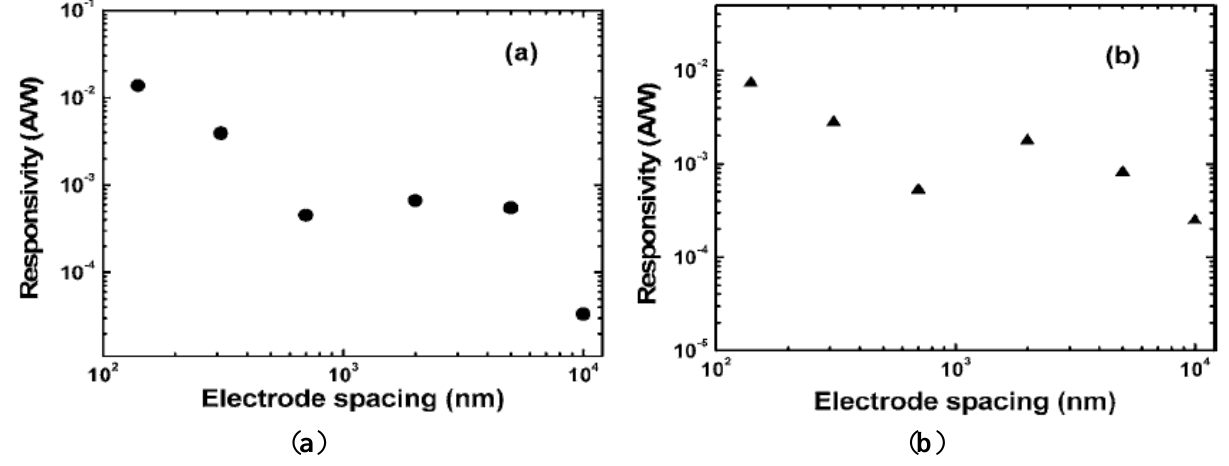
Figure 13. Dependence of the responsivity at 220 nm light on the electrode spacing ( a ) at a fixed voltage of 1 V and ( b ) at an electric field of 2 × 10 4 V/cm (reprinted from Reference